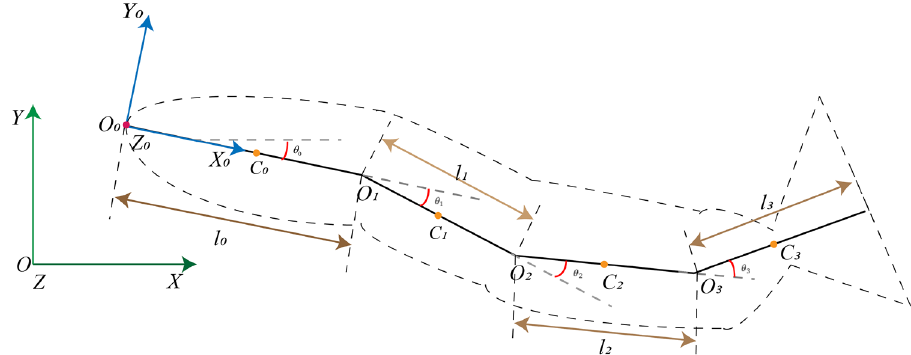
Fig. 4 Schematic illustration of coordinate systems according